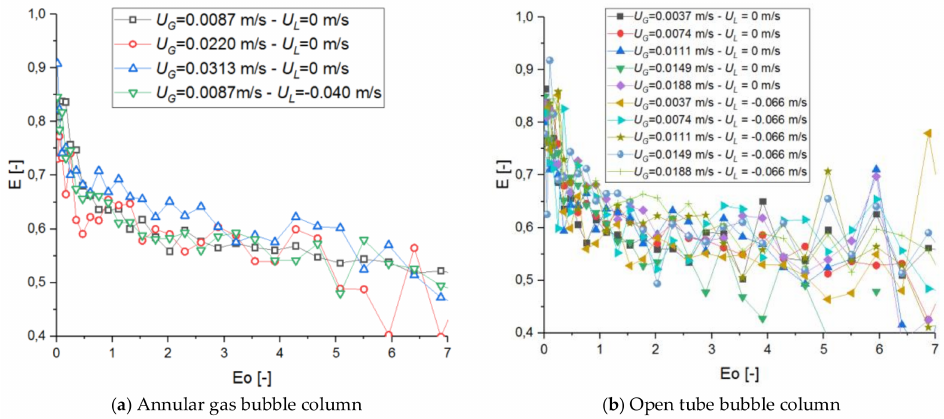
Figure 26. Influence of the gas and liquid superficial velocities on E (PoliMi bubble columns